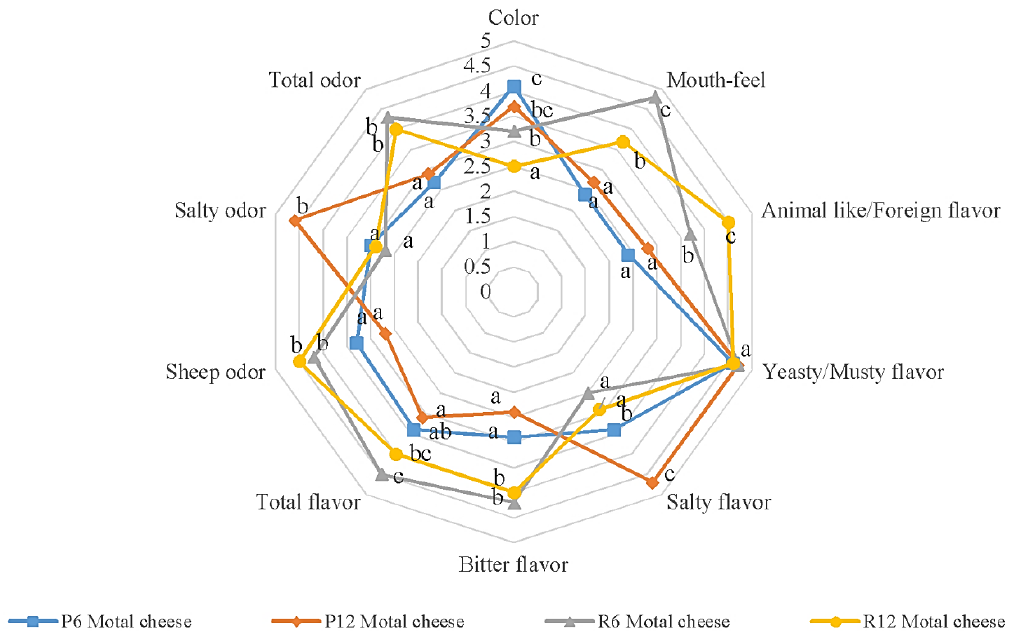
a, b, c Data di ff er significantly